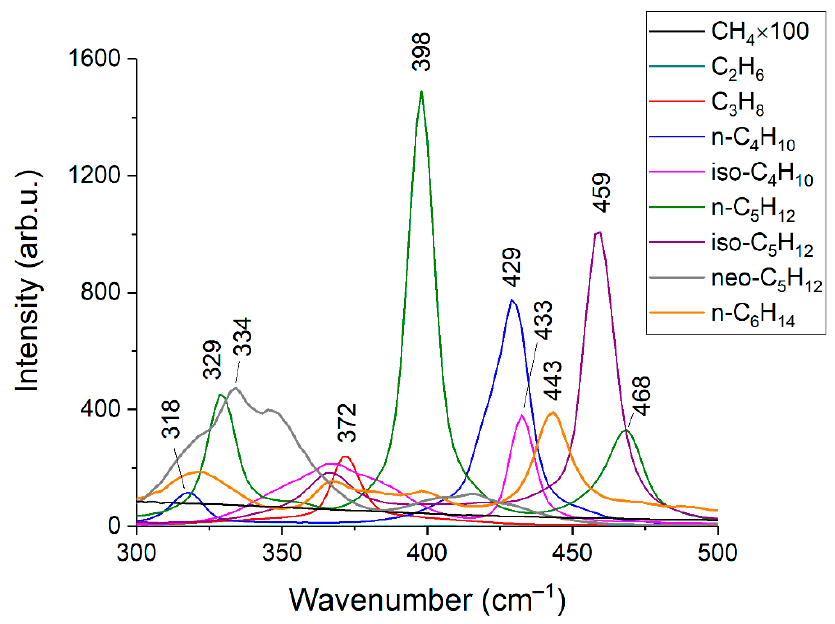
Figure 4. Raman spectra of C1–C6 alkanes in the range of 300–500 cm − 1 . The intensities correspond to the equivalent pressure.